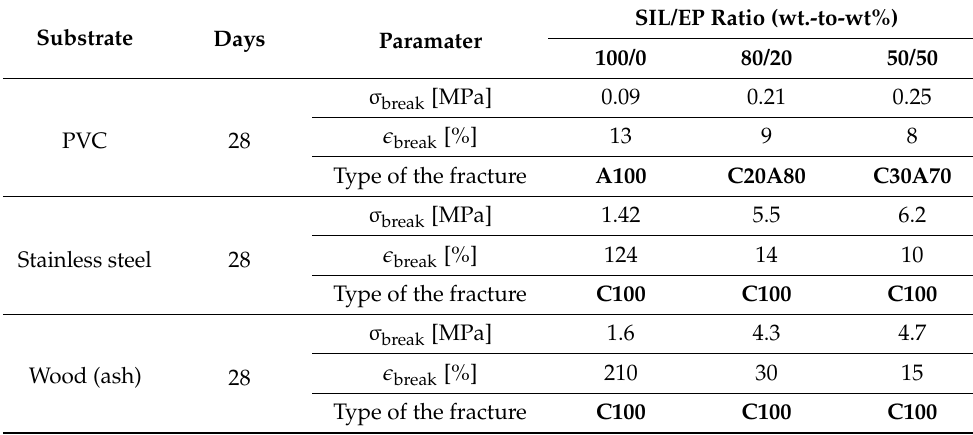
Table 5. Lap shear tests of two component SIL/EP-completed